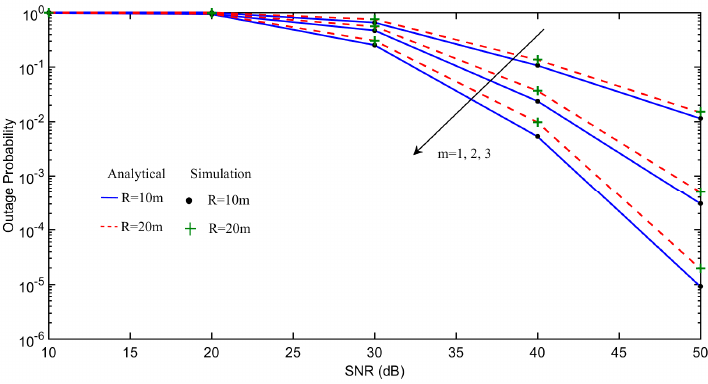
Figure 2. Impact of R on outage probability of each m -th user.